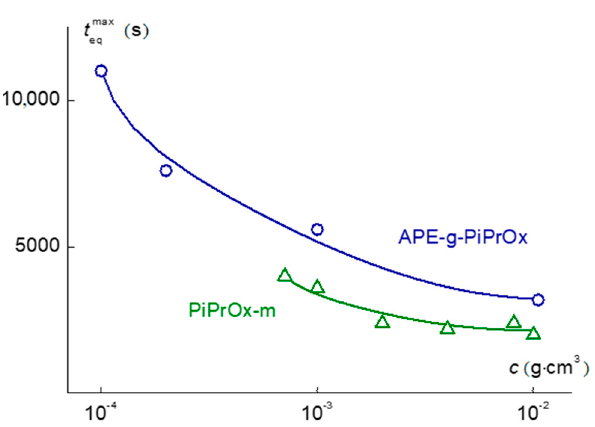
Figure 13. Concentration dependences of t max eq for APE-g-PiPrOx and PiPrOx-m solutions.